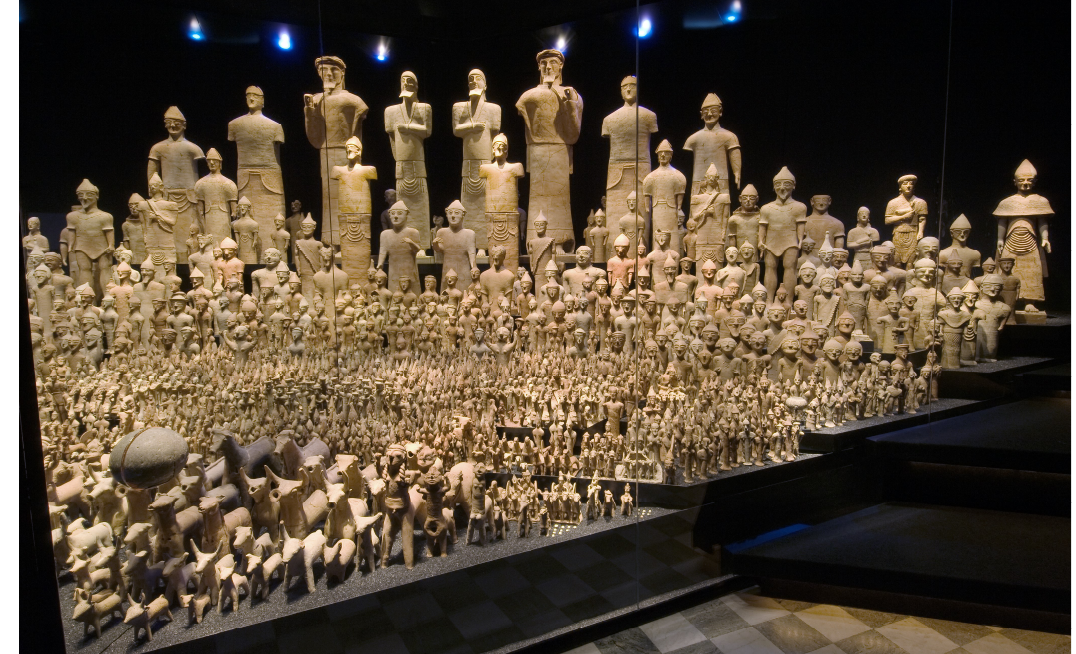
Figure 2. The Agia Irini showcase at the Medelhavsmuseet, Stockholm, © Medelhavsmuseet.